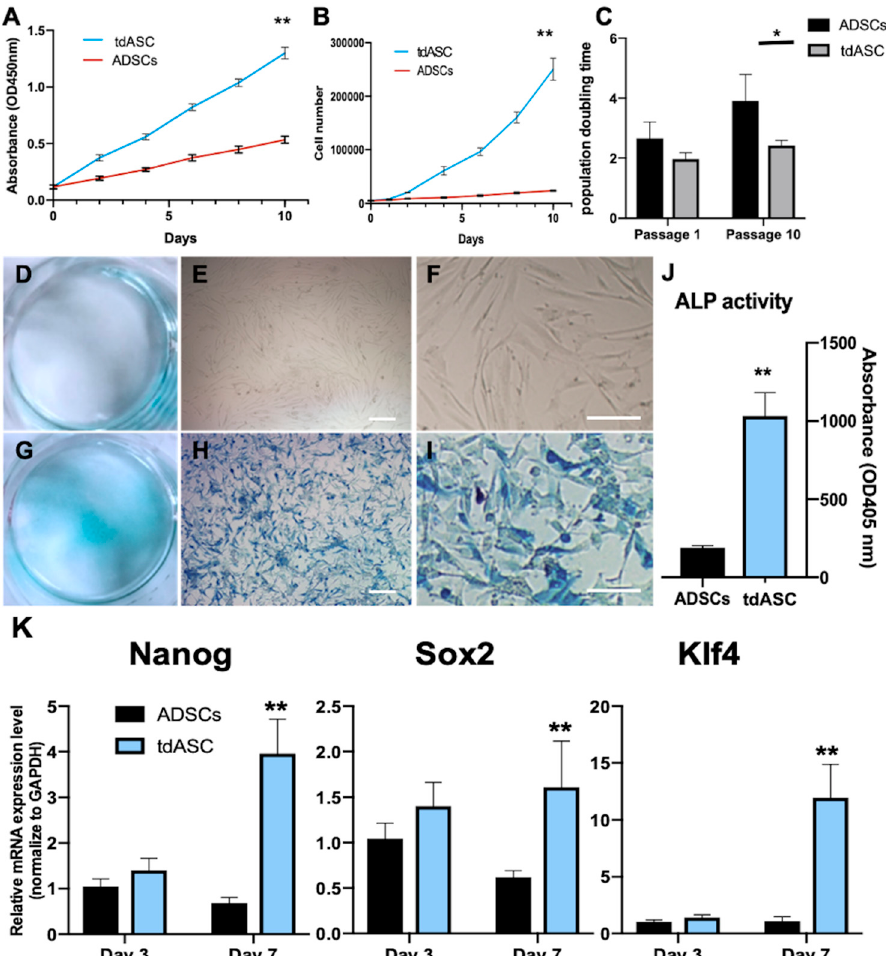
Figure 3. Characterization of tdASC and ADSC proliferation and senescence. ( A ). Cell counting kit 8 (CKK-8) assay. tdASC cell lines showed a significant increase in proliferation; n = 5; ** p < 0.01. ( B ). Cell counting plot for tdASC and ADSCs; n =